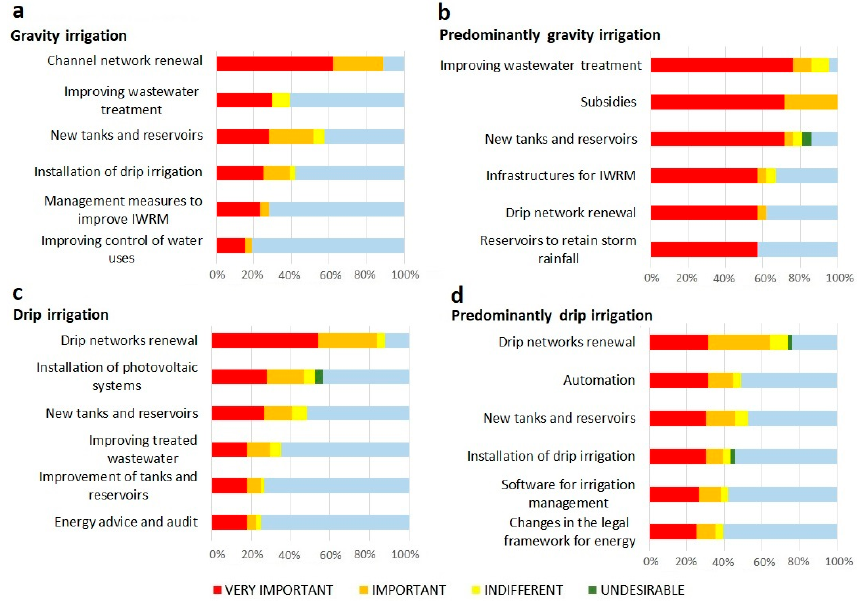
Figure 8. Measure evaluation according to irrigation technique: evaluated in terms of percentage of total votes. ( a ) Gravity irrigation; ( b ) Predominantly gravity irrigation; ( c ) Drip irrigation; ( d ) Predominantly drip irrigation.